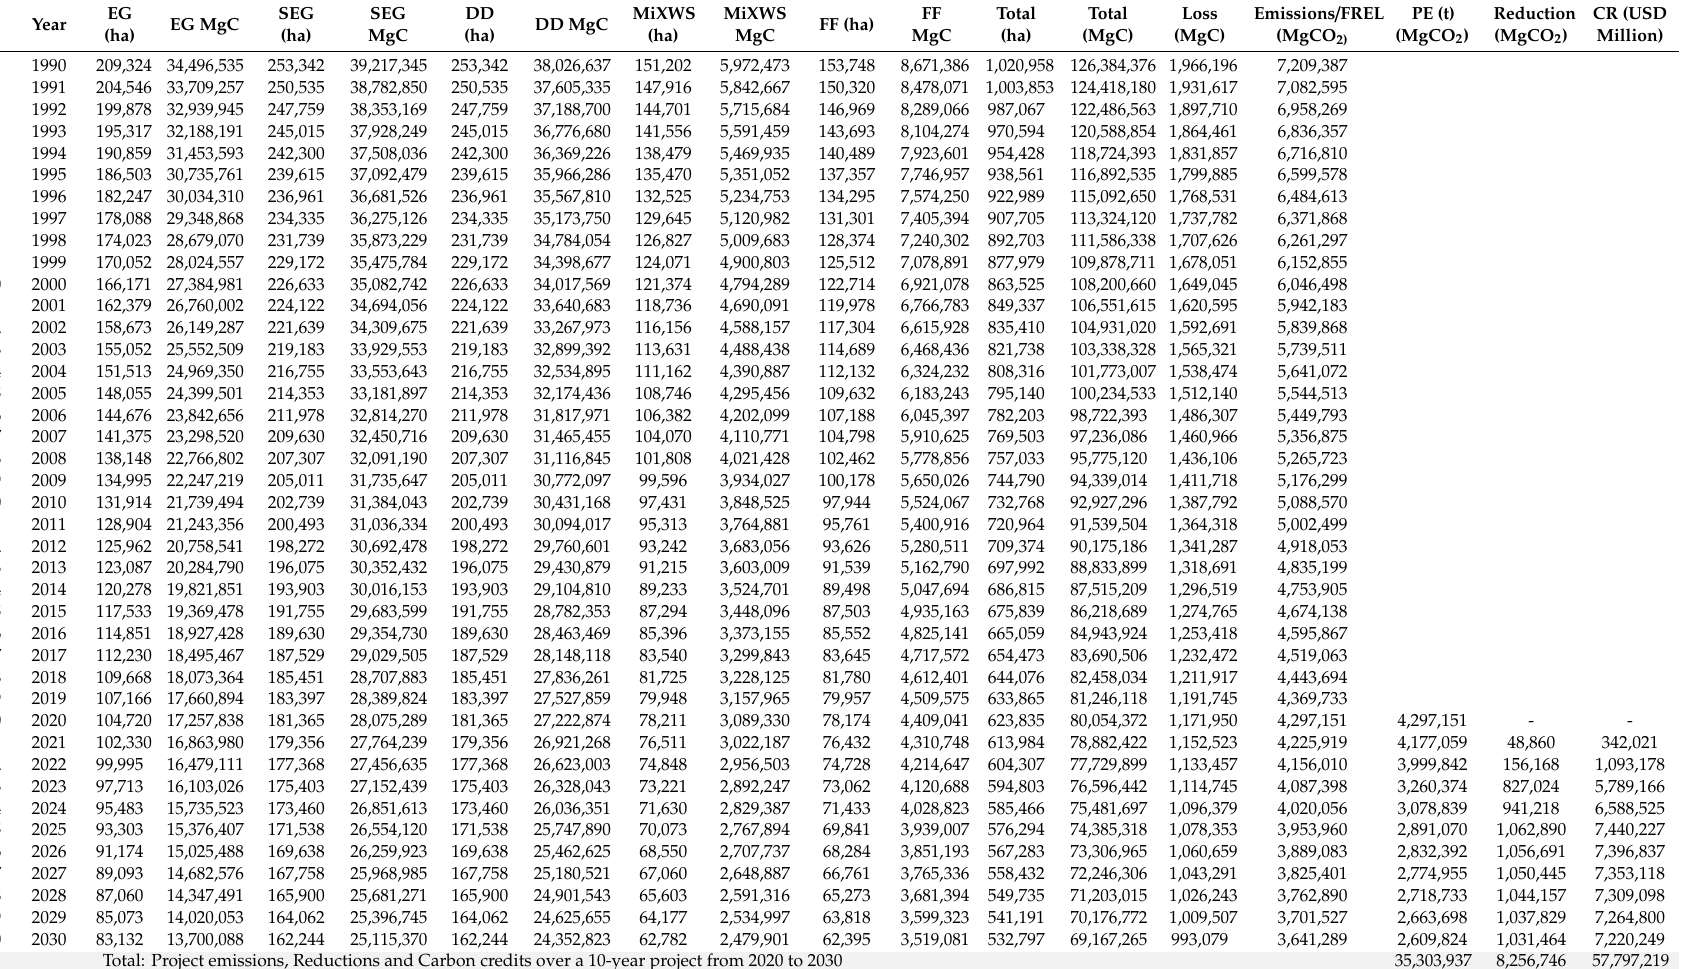
Table A11. Carbon emissions, FREL, Project Emission, Reductions, and Carbon revenues in Siem Reap province from 1990 to